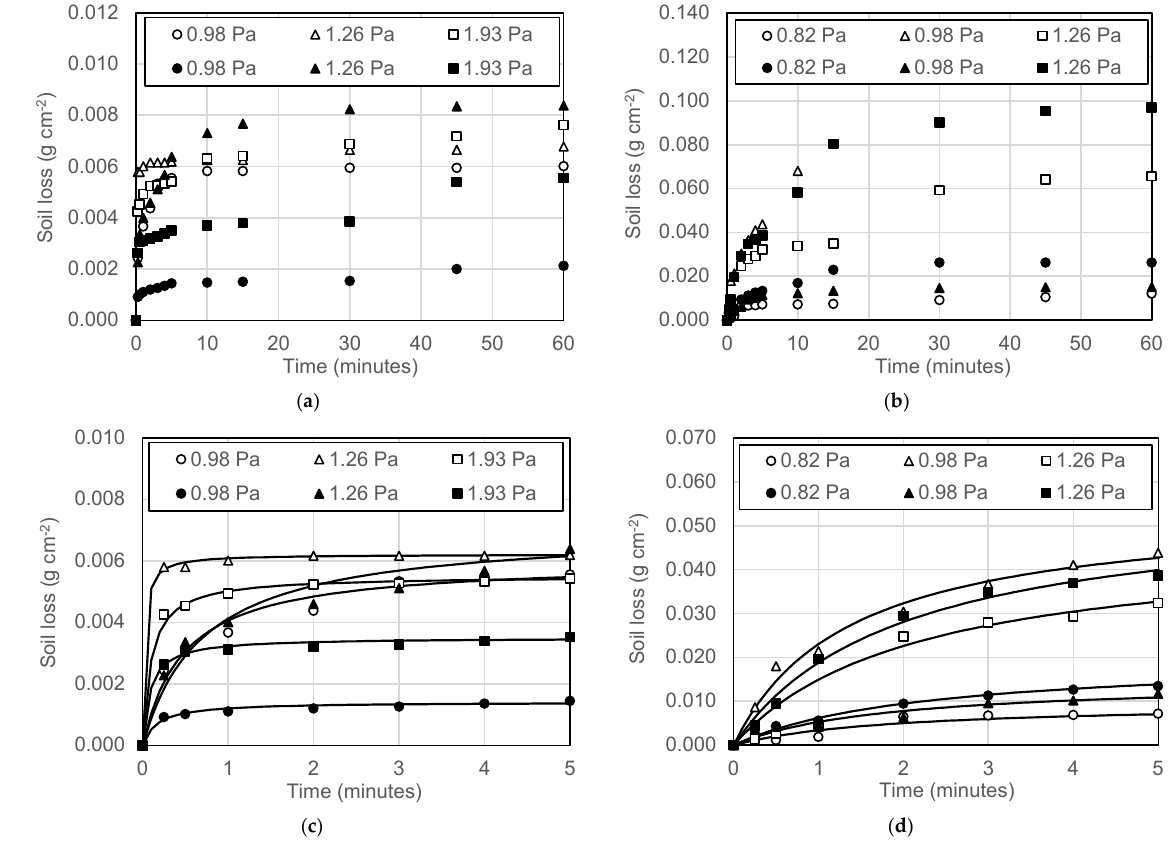
Figure 3. Flume test results for void ratios of: ( a ) 1.0; ( b ) 1.5; ( c ) 1.0 modelled curves; and ( d ) 1.5 modelled curves. Filled and empty markers of the same shape indicate test pairs that were conducted under identical conditions.